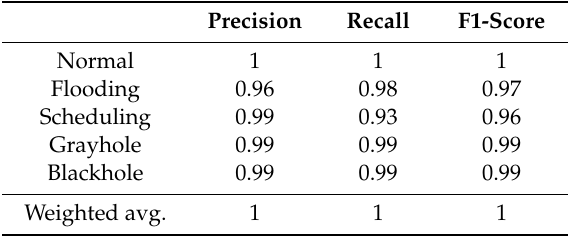
Table 10. Precision, recall, and F1-score results of the holdout method. Precision Recall